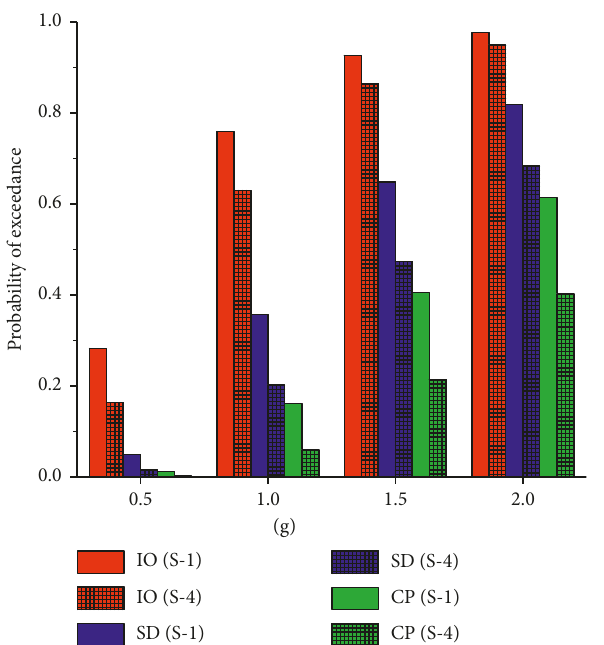
Figure 14: Impact of sheathing thickness on seismic fragility.